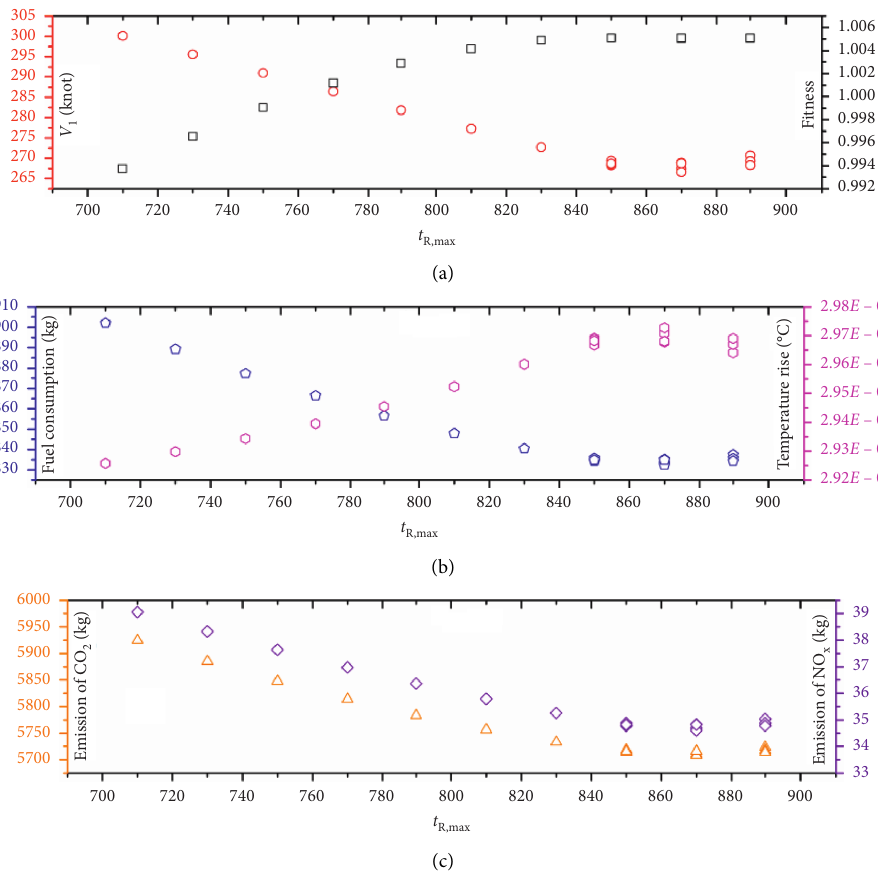
Figure 12: Effect of t R, max on optimization